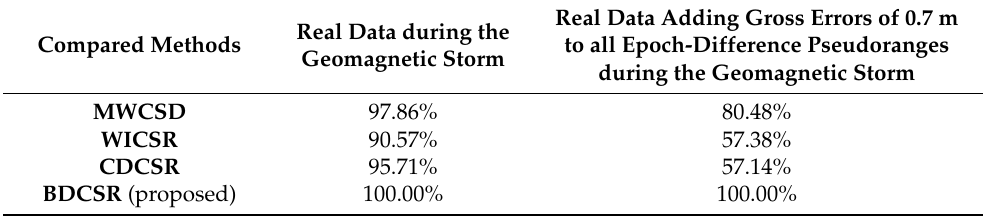
Table 6. The success rates of various compared methods from all BDS satellites at high latitudes of RGDG and